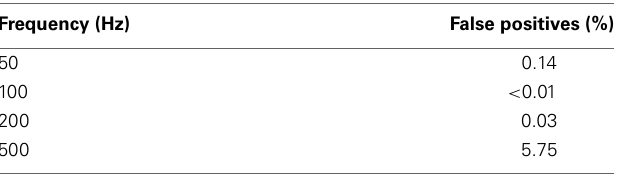
Table 1 | Performance of the line extraction algorithm.